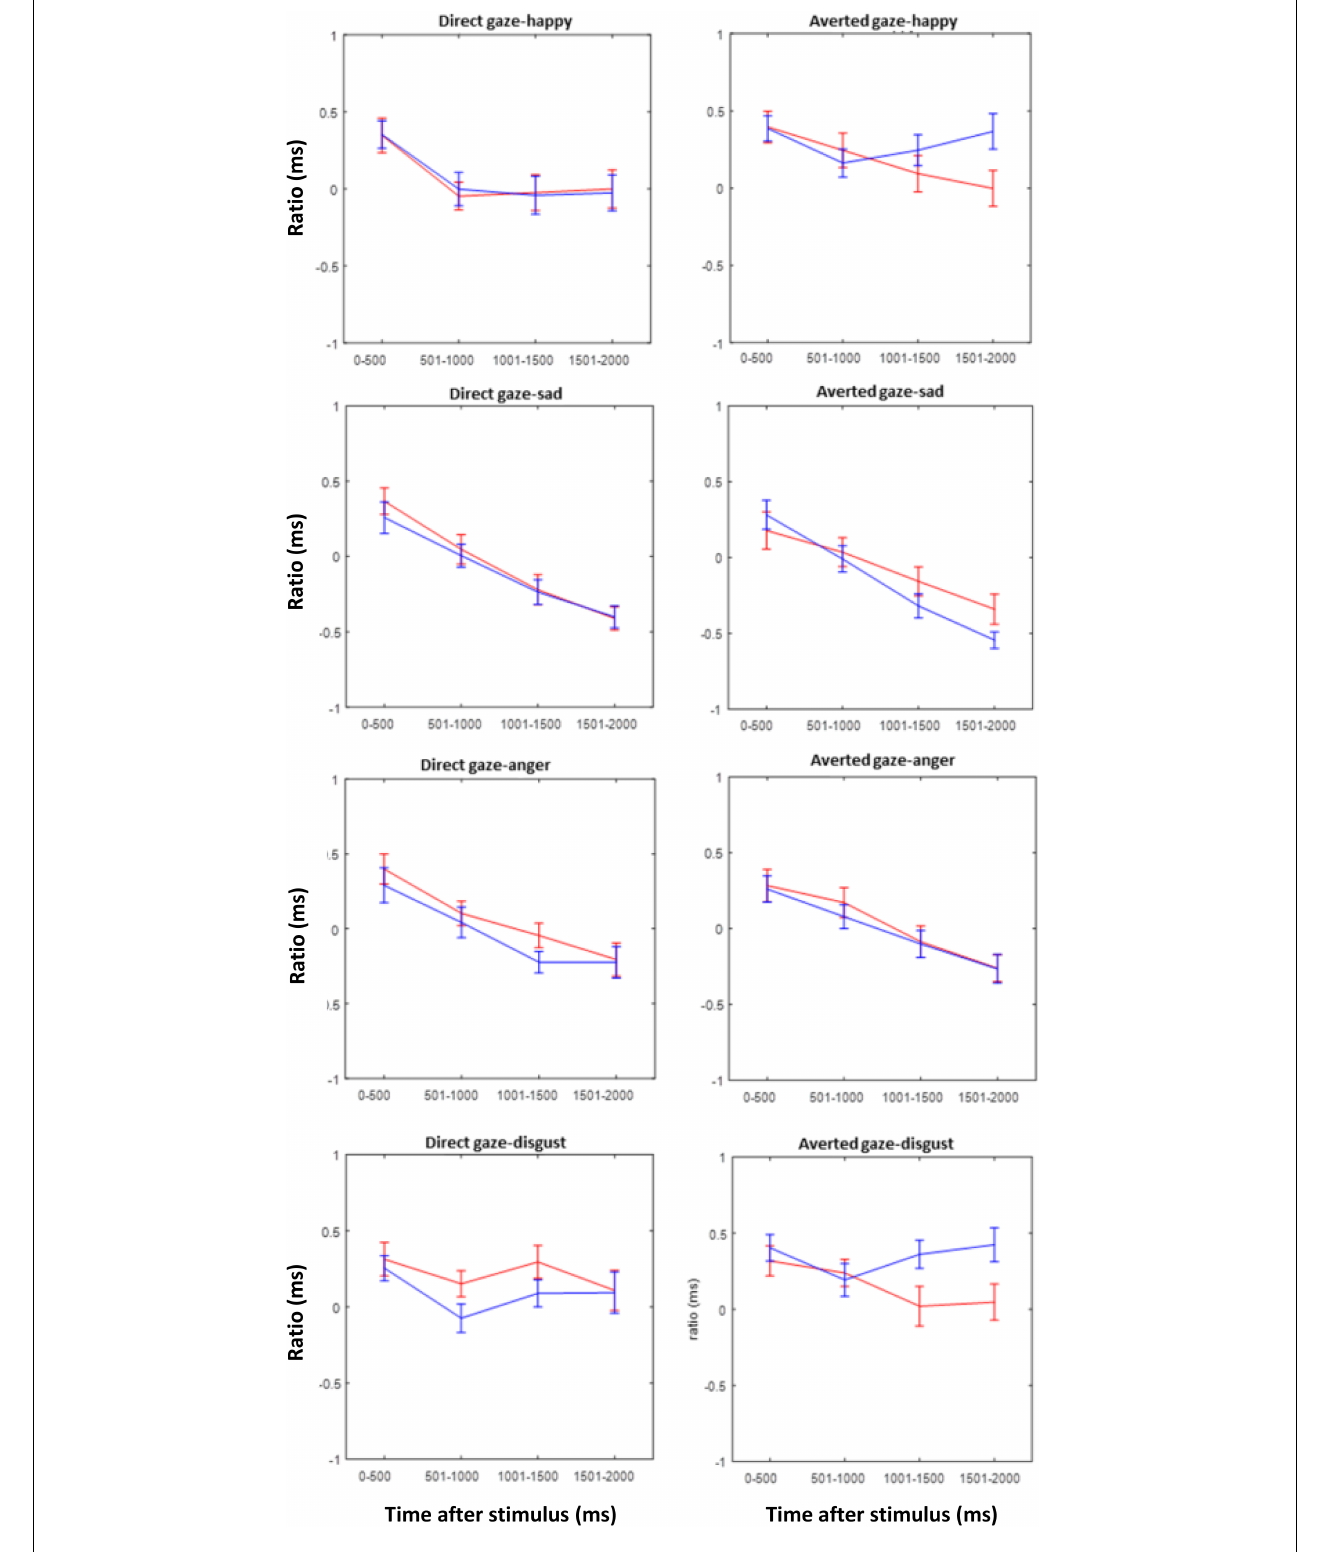
FIGURE 8 | Eye avoidance index (EAI) for the ASD (red) and TD (blue) groups during the first 2 s after stimulus presentation in intervals of 500 ms for all emotions and both gaze directions of the stimulus faces.